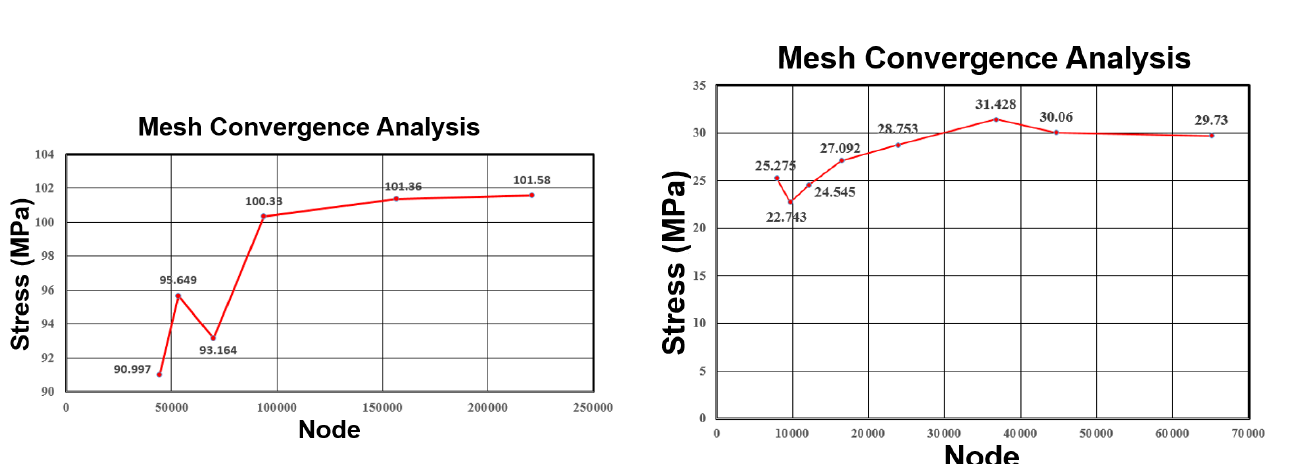
Figure 29. Knuckle convergence map.